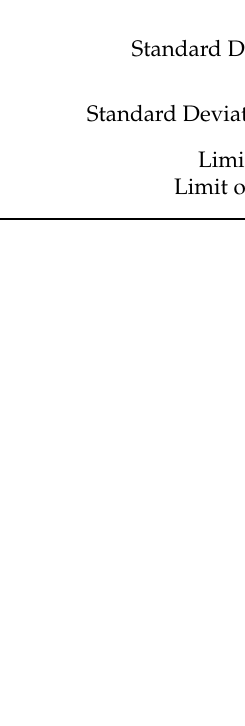
Table 3. In situ data of water, river, and well samples in the